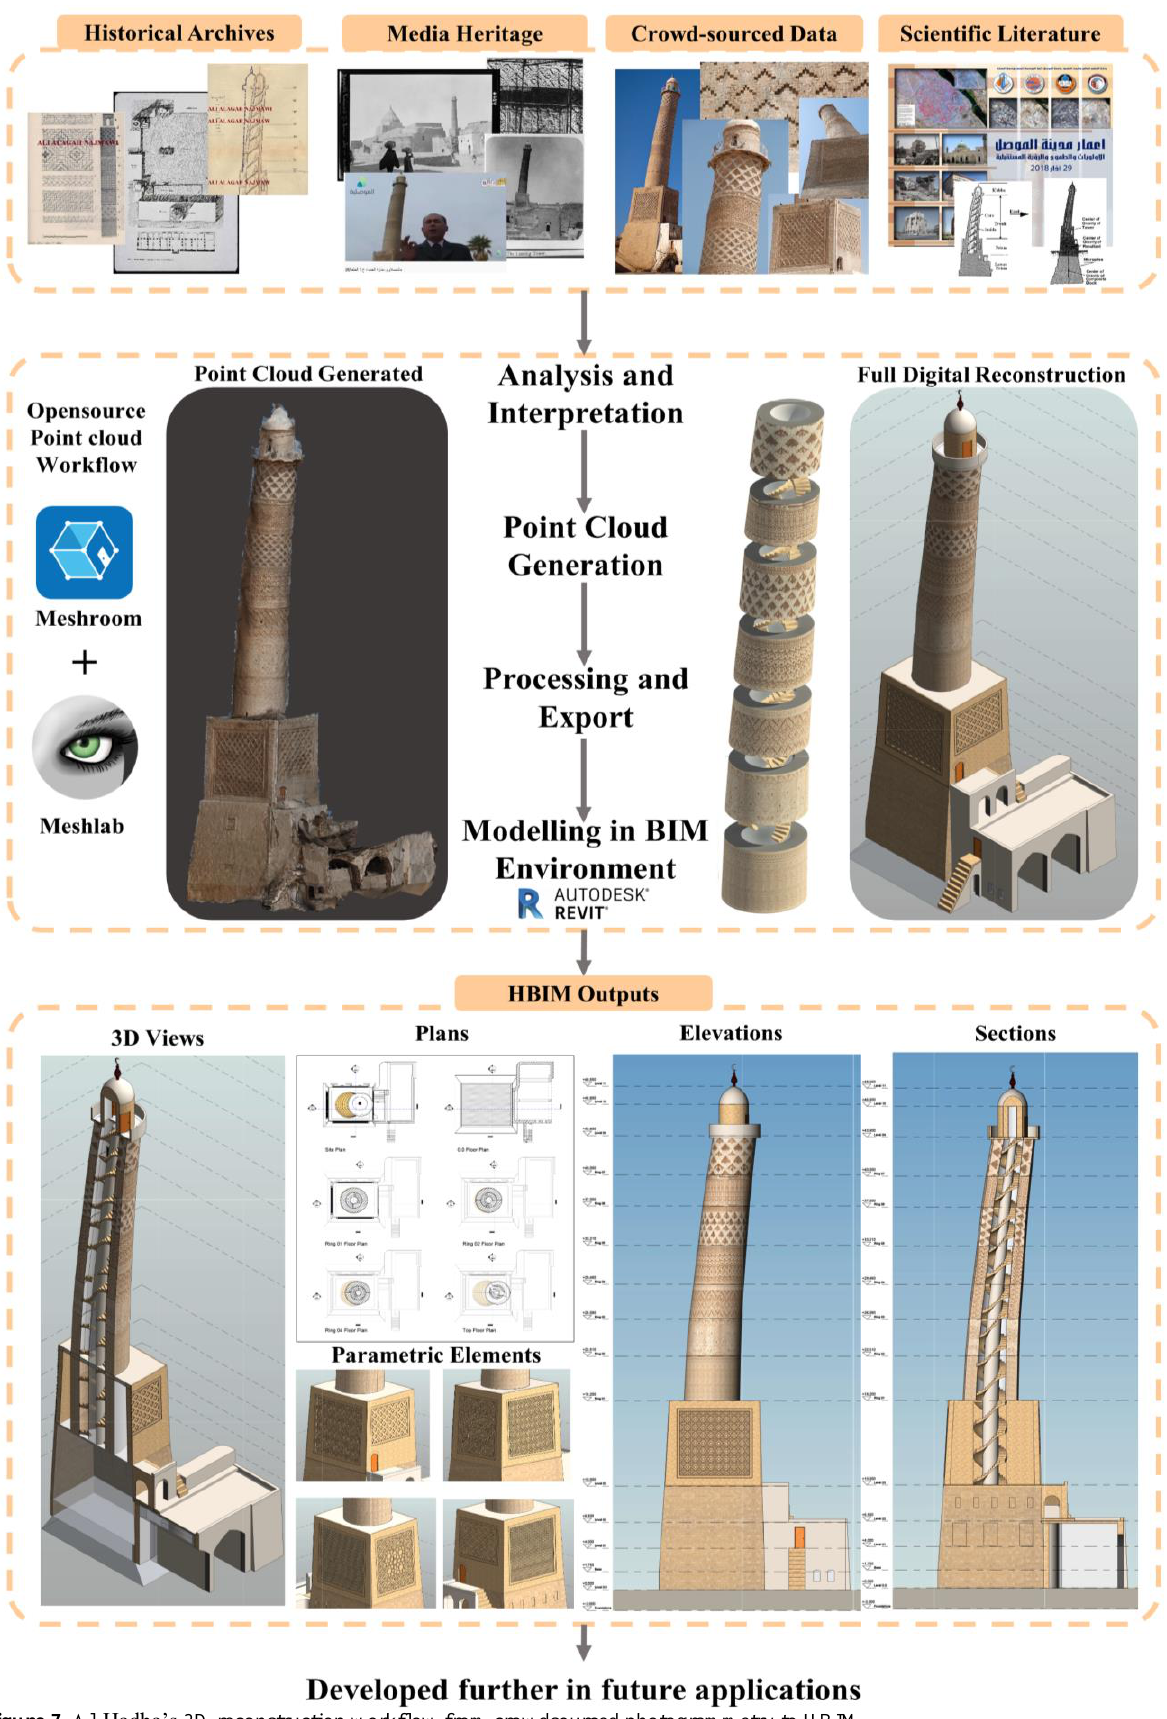
Figure 7. Al-Hadba’s 3D reconstruction workflow from crowdsourced photogrammetry to